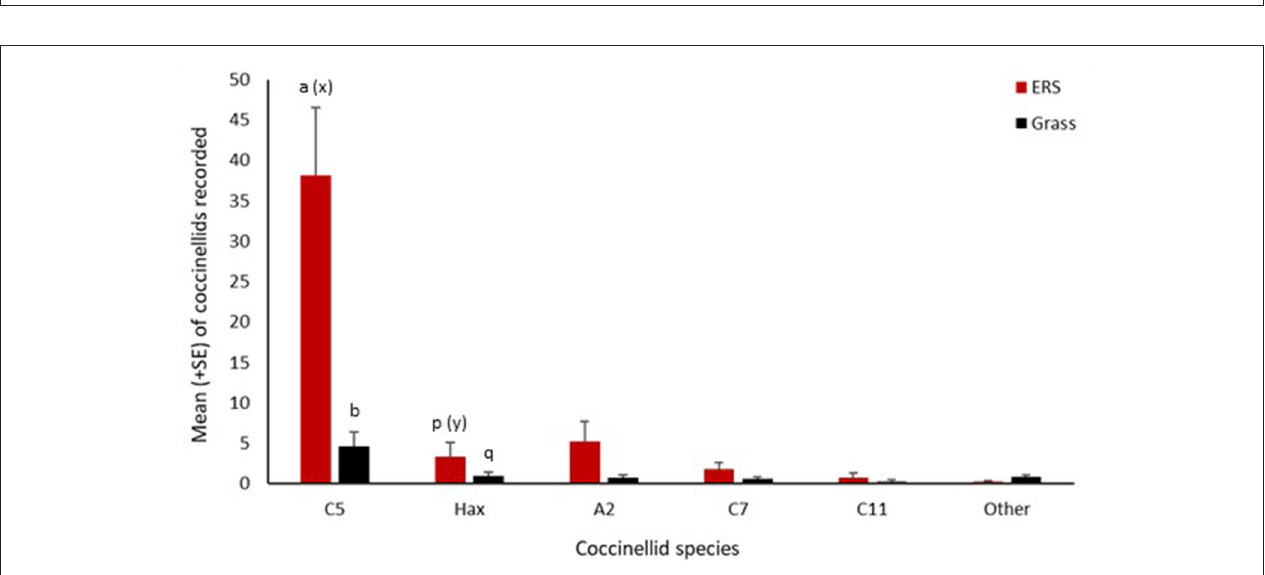
FIGURE 3 | Mean number ( + SE) per site visit of coccinellids recorded on ERS and grassland in Wales in 2017. C5, Coccinella quinque punctata ; Hax, Harmonia axyridis; A2, Adalia bipunctata ; C7, Coccinella septempunctata ; C11, Coccinella undecimpunctata ; Other , Propylea quattuordecimpunctata, Psyllobora vigintiduopunctata, Subcoccinella vigintiquattuorpunctata, and Tytthaspis sedecimpunctata. Consecutive letters indicate where significant differences